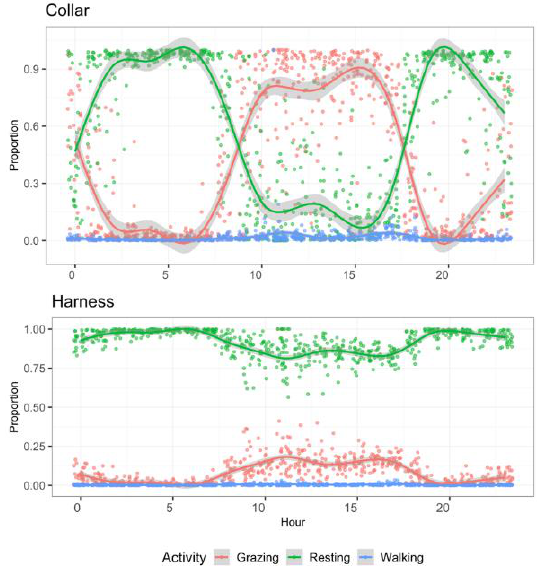
Figure 4. Mean daily activity budgets of ewe lambs ( n = 10) per hour of day allocated to three